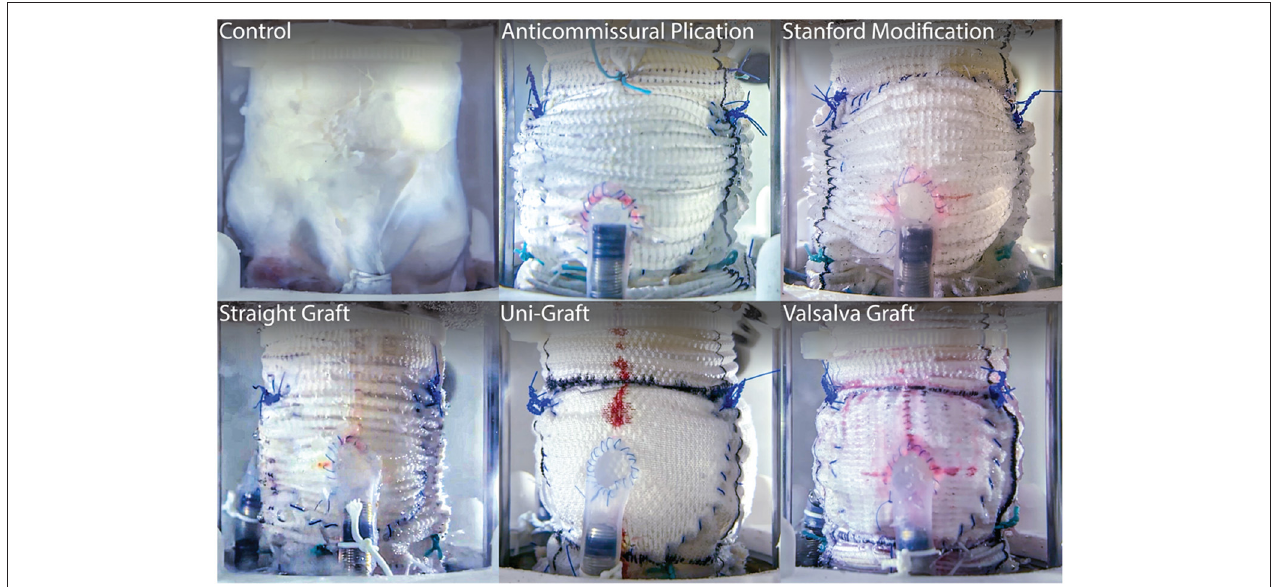
FIGURE 2 | Long-axis view of five clinically used conduit configurations for VSARR, mounted within an ex vivo left heart simulator and attached to coronary circulation. Ex vivo experimentation allows for highly controlled, direct comparisons of surgical techniques, helping to identify optimal treatments and prostheses. Reprinted from Paulsen et al. (